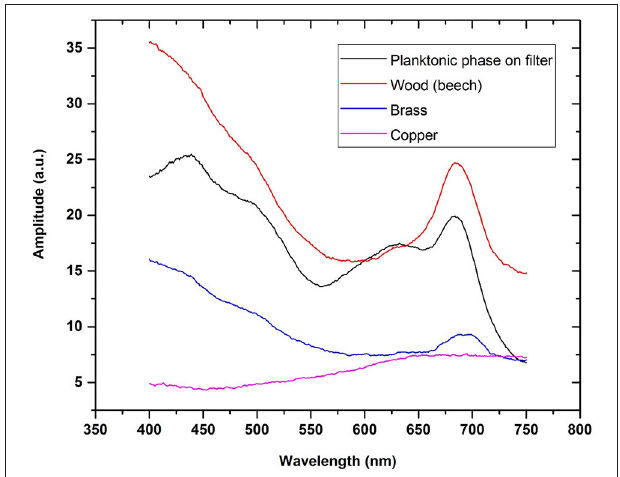
FIGURE 12 | Biofilm substratum effect on PA signal amplitude spectra. Biofilm samplers deployed in Baltic Sea coastal waters; sampling time 14